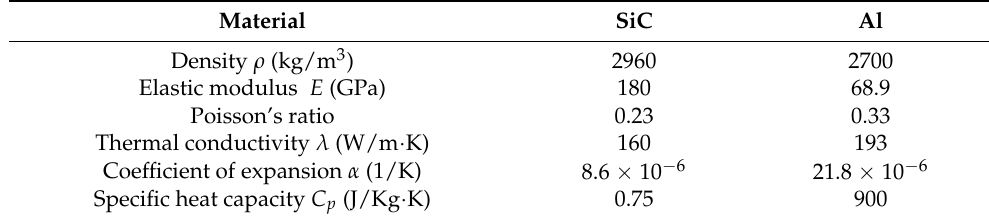
Table 2. Material property parameters.